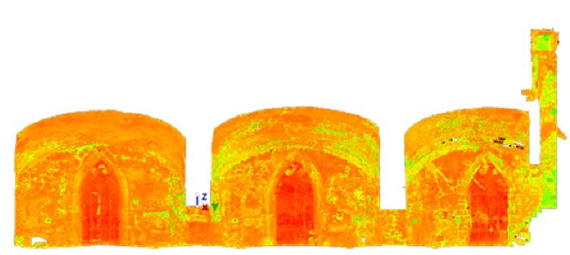
Figure 3. The C10 point cloud, about 440 million points, 13 GB.